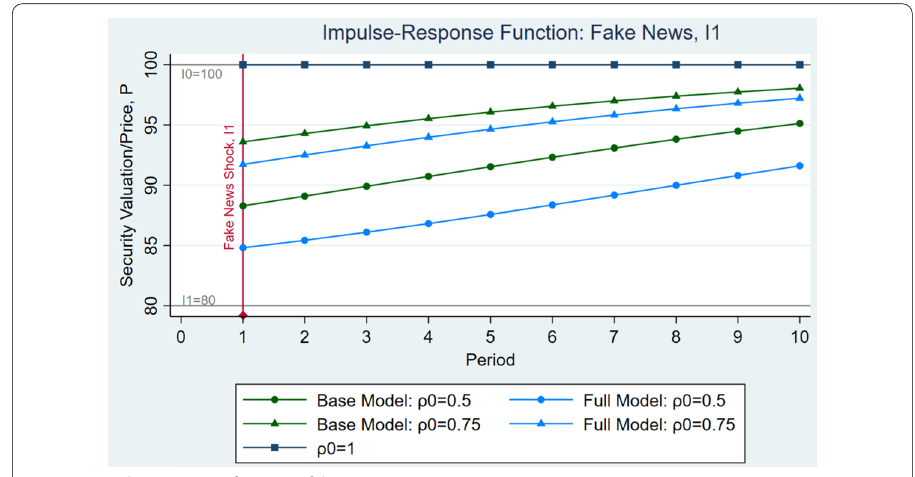
Fig. 2 Impulse-response function: fake news,